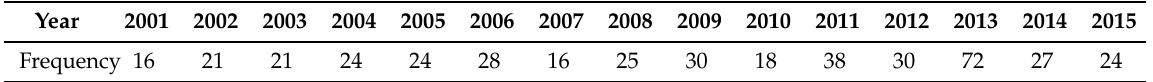
Table 1. Earthquake frequency around the Korean Peninsula for the last 15 years.